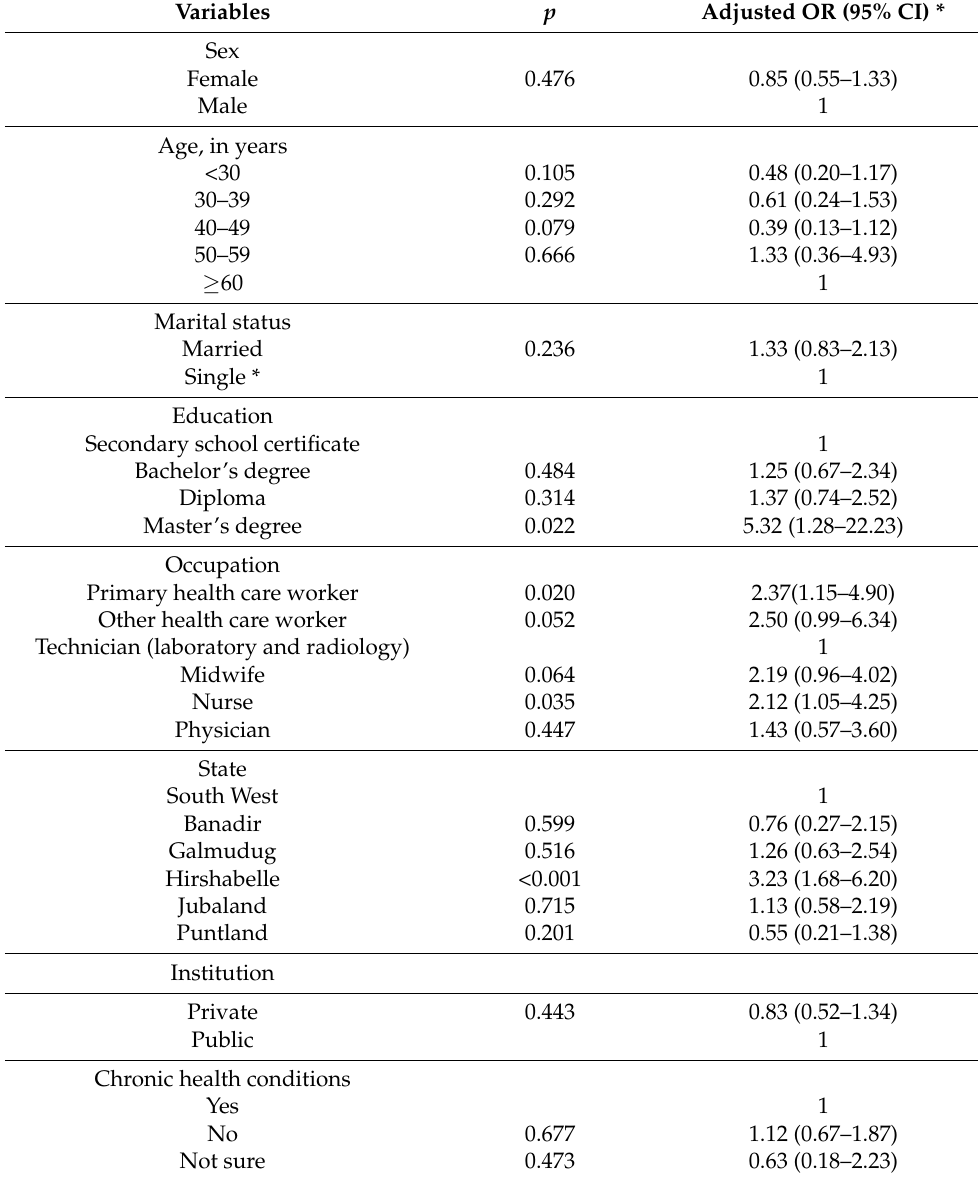
Table 6. Multivariable logistic regression analysis of predictors of COVID-19 vaccine hesitancy among Somali health